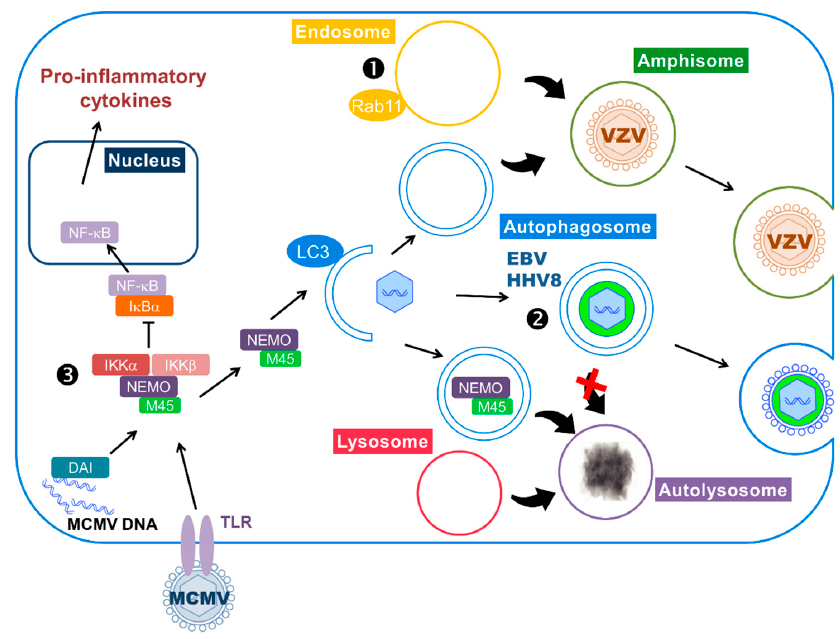
Figure 2. Subversion of autophagy during the lytic cycle. (cid:202) , (cid:203) Herpesviruses can use autophagy-derived vesicles for their transport within the cytoplasm and their release. (cid:202) VZV particles are incorporated in amphisome, a vacuole resulting from the fusion of autophagosome and endosome. (cid:203) Autophagosomes transport HHV8 and EBV particles to the cell surface. The viruses block autophagosome fusion with the lysosome to avoid degradation (red × ). Moreover, EBV uses autophagosomal membrane for secondary envelopment and LC3 can be found in the virion. (cid:204) MCMV infection triggers the inflammatory cascade, via activation of TLRs and DAI (DNA-dependent activator of interferon regulatory factors), leading to nuclear translocation of NF- κ B and transcription of pro-inflammatory cytokines. The viral protein M45 targets NEMO (NF- κ B Essential Modulator), a protein involved in the activation of NF- κ B, and redirects it to autophagosomes, where it will be degraded after fusion with the lysosome.